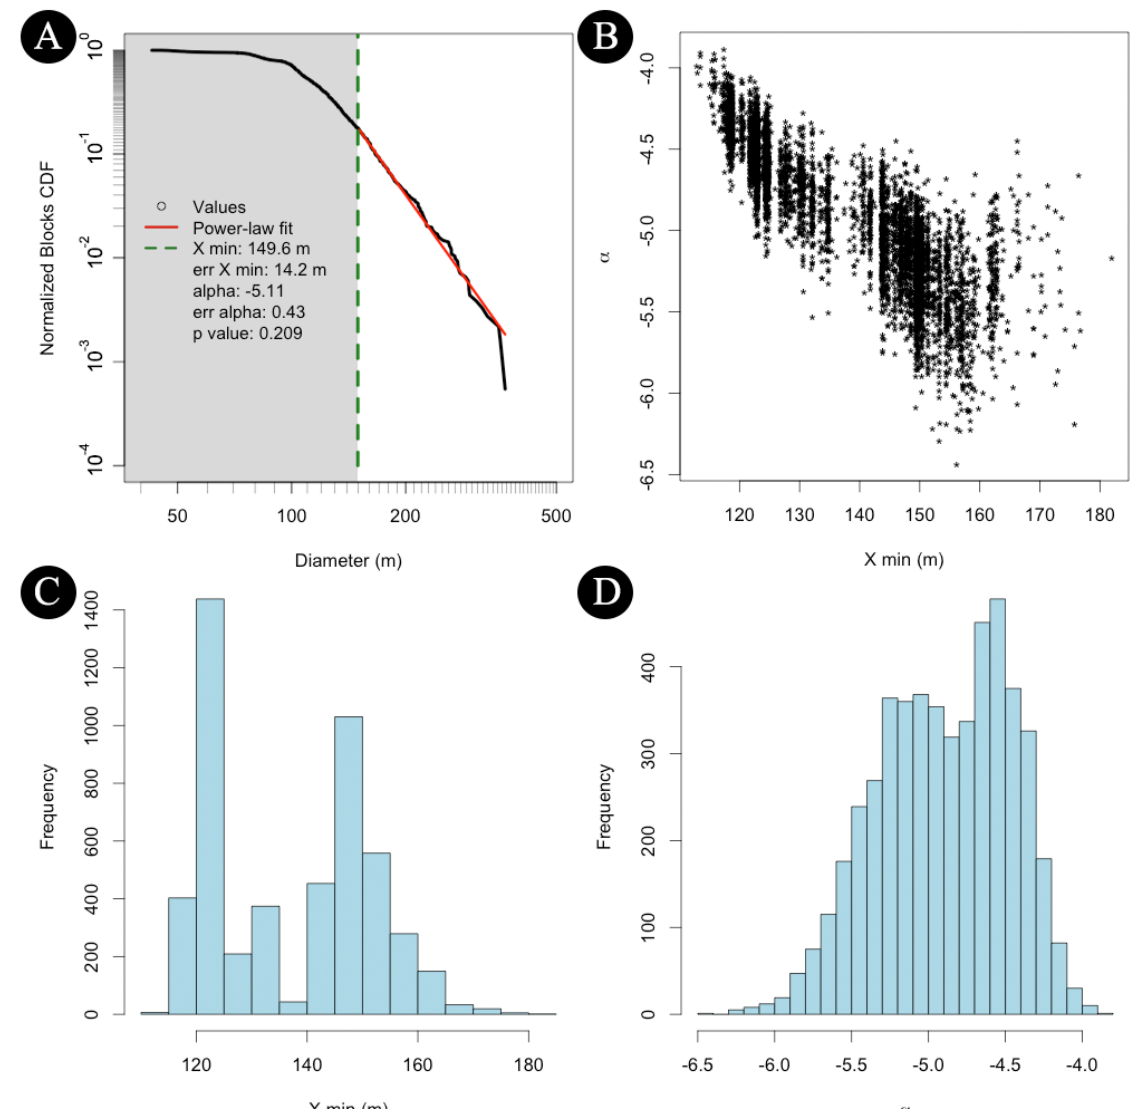
Figure 9. The Damascus case study. ( A ) Normalized cumulative distribution function showing the obtained sizes, the power-law fitting curve and the x min limit (the grey shadowed area is not considered by the fit). The total number of blocks larger than x min and used for the fit is 327. ( B ) Scatter-plot of x min against 𝛼 resulting from 5000 synthetic datasets. ( C ) Frequency histogram of x min . ( D ) Frequency histogram of the power-law index 𝛼 .